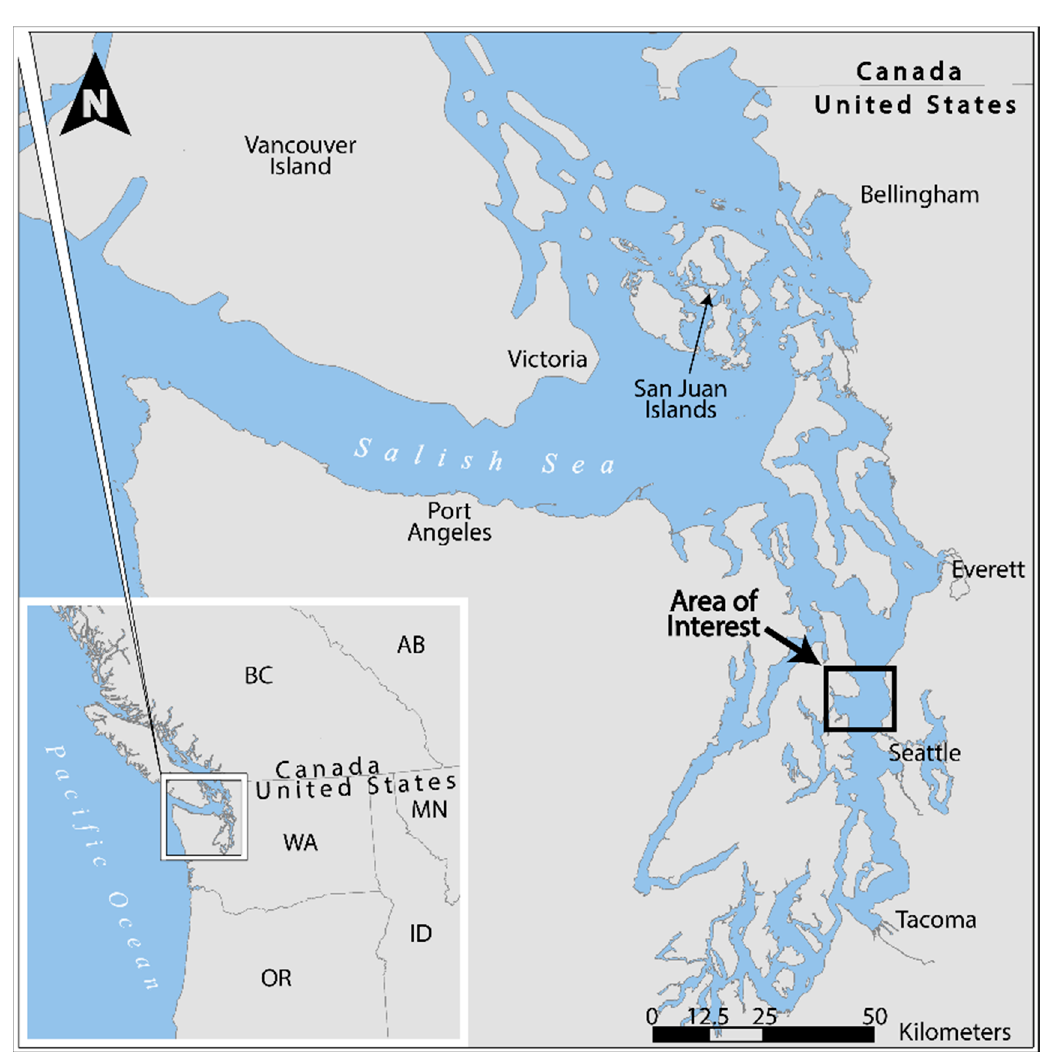
Figure 2. Maps showing the study area in the Salish Sea and surrounding areas.